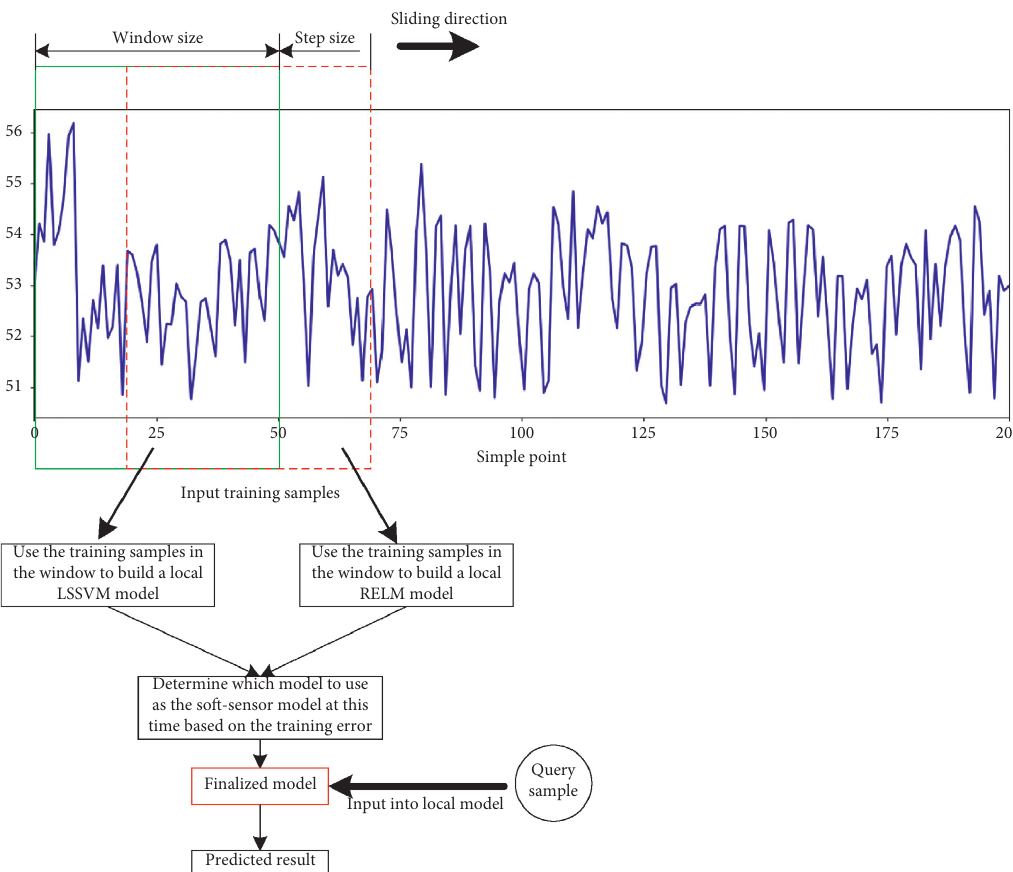
Figure 5: Schematic diagram of the implementation of the hybrid soft-sensor model.